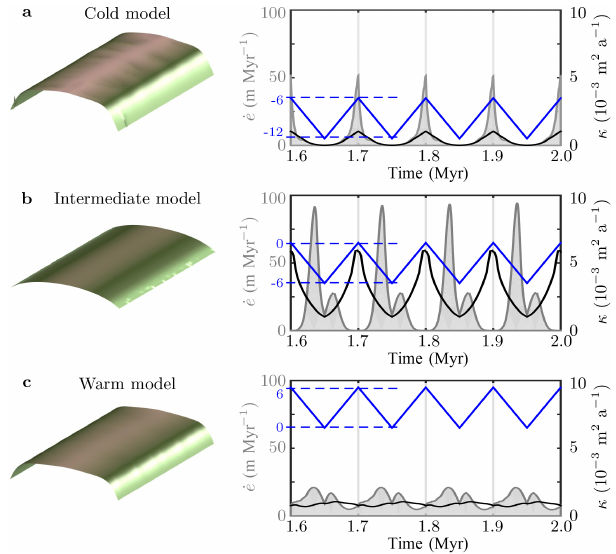
Figure 6. Development of a summit flat under three different cli- matic scenarios: (a) a cold model ( − 12 < MAT < − 6 ◦ C); (b) an intermediate model ( − 6 < MAT < 0 ◦ C, same as Fig. 5); and (c) a warm model (0 < MAT < 6 ◦ C). Final topography at 2Myr is shown in left panels. Right panels show time series of temperature (blue), average frost-cracking rate ( ˙ e , grey), and sediment diffusiv- ity ( κ , black) over four climate cycles between 1.6 and 2.0Myr after simulation start. Note that frost cracking and frost creep are in-phase for the cold model but out-of-phase for the intermediate and warm models.